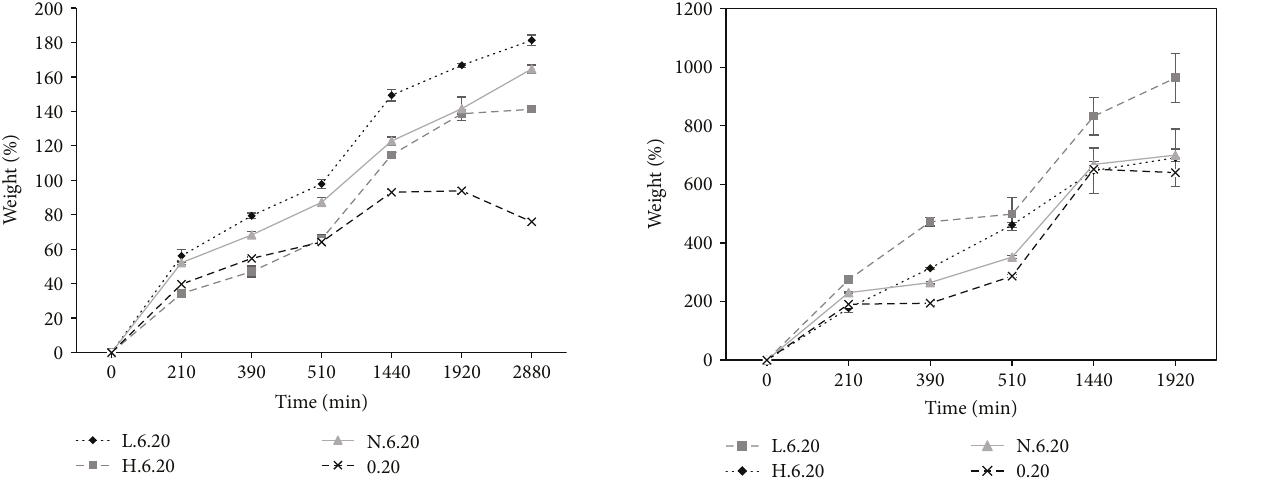
Figure 5: Swelling kinetics of aerogels (lyophilized hydrogels). The samples used for this study were H.6.20 (6% HOP and 20% of gelatin), L.6.20 (6% LOP and 20% of gelatin), N.6.20 (6% NOP and 20% of gelatin), and 0.20 solely gelatin (20% gelatin).